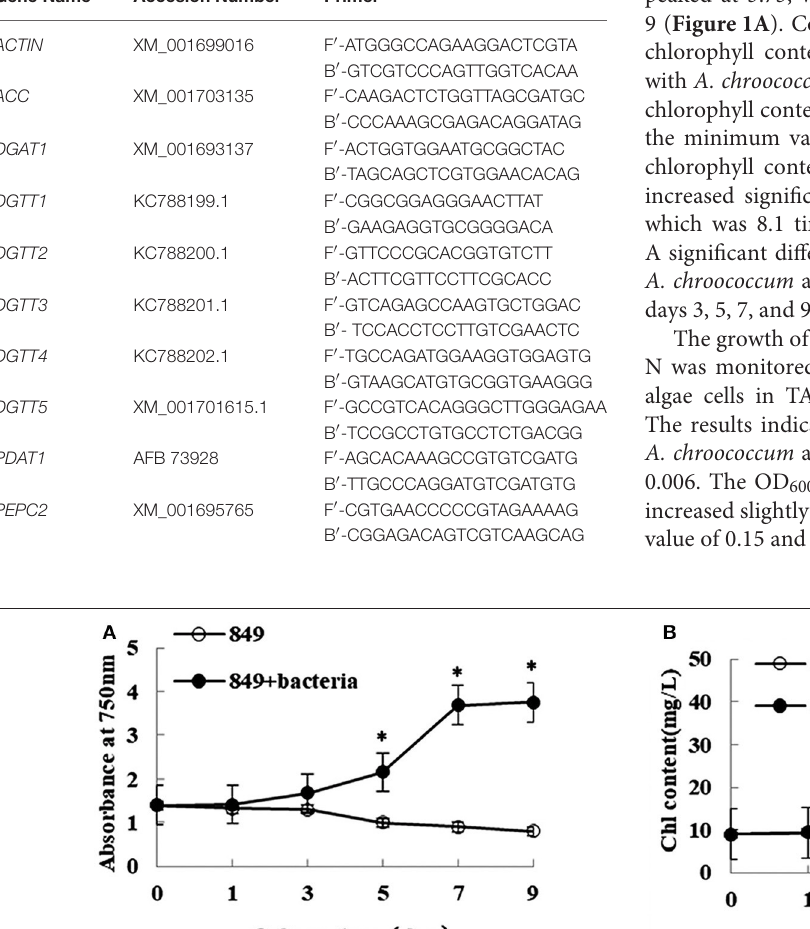
Frontiers in Plant Science |